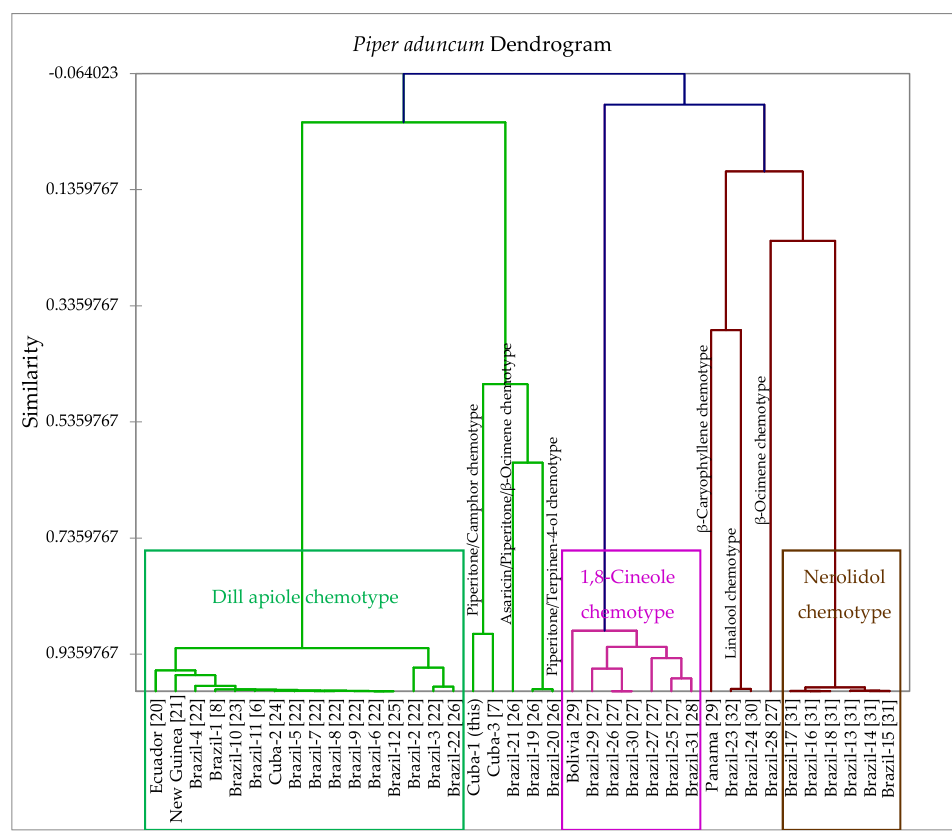
Figure 3. Dendrogram acquired from the agglomerative hierarchical cluster analysis of 38 Piper aduncum essential oil compositions.